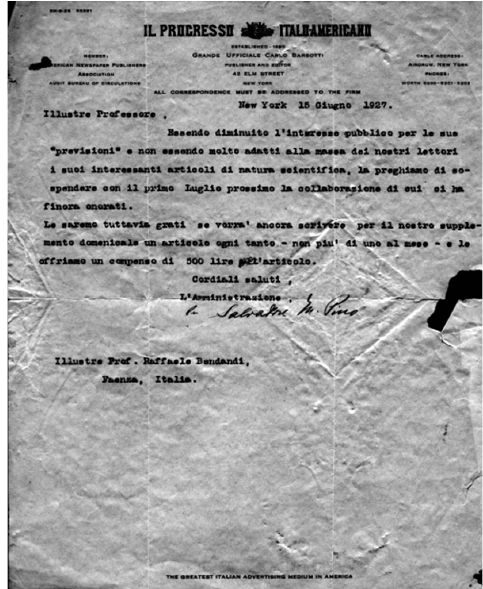
Fig. 7. Salvatore Pino director of the newspaper Il Progresso Italo-Americano of New York asks «the il- lustrious Professor to suspend from the 1st July the collaboration that he has hitherto honoured us with» , as the public’s interest in his forecasts had dimi- nished. The articles of a scientific nature written by Bendan- di are addressed to an over-limited circle of readers, so he is offered a periodic and no longer systematic collaboration, with a fee of 500 lire per